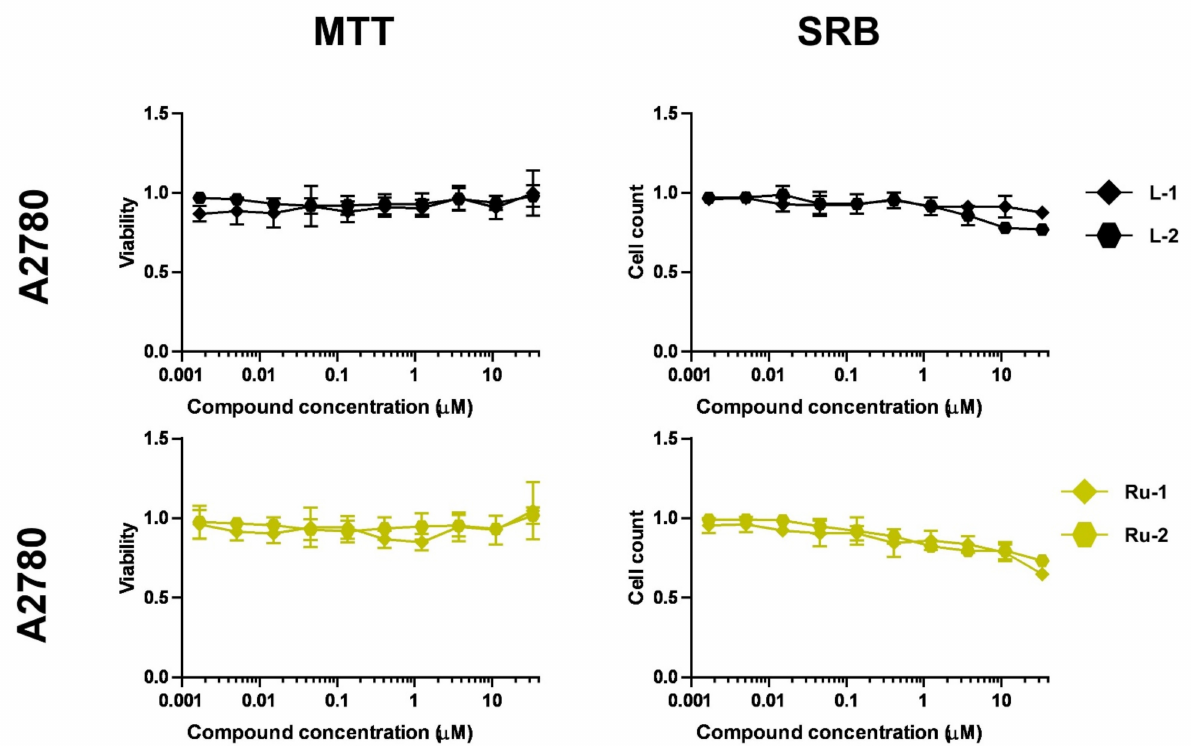
Figure 4. Assessment of free ligands L-1 and L-2 and ruthenium complexes Ru-1 and Ru-2 in terms of cytotoxic and cytostatic activity. Briefly, 3 × 10 3 A2780 cells were plated onto 96-well plates. Cells were treated with the compounds in the concentrations indicated, for either 4 h for an MTT assay or 48 h for an SRB assay. Data are represented as average ± SD, from three biological replicates; individual assays were performed in duplicate. Values were normalized for vehicle-treated cells; absorbance for vehicle-treated cells is equal to 1. A one-way ANOVA, followed by a Kruskal–Wallis test, was performed individually for each compound. The results of the statistical analysis are presented in an Excel spreadsheet at https://figshare.com/s/28d14597d5041f08eb08 (accessed on 6 January 2022). Nonlinear regression was performed on the